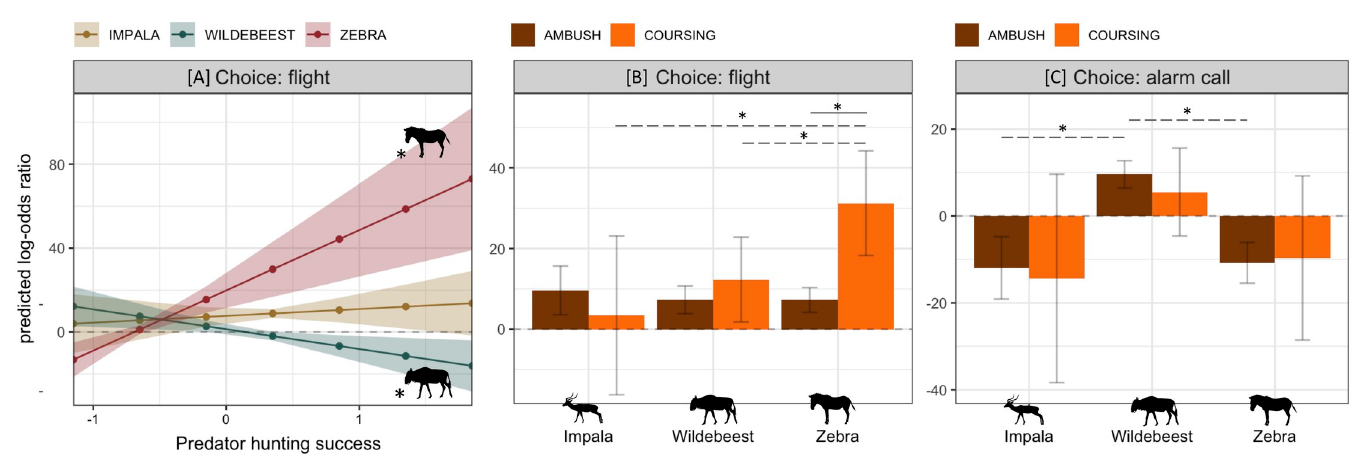
Fig 4. Strongly-supported effects on type of anti-predator behaviors chosen. [A] Zebra and wildebeest were more and less likely to flee, respectively, from increasingly successful predators. [B] Zebra were more likely to flee from coursing predators than ambush predators and fled more often from coursing predators than either impala or wildebeest did. [C] Wildebeest were increasingly likely to alarm-call in encounters with ambush predators than either impala or zebra. Depicted are log-odds ratios with associated 95% CIs. Ratios above and below 0 (dashed line) indicate that the outcome is more or less likely. For [A] and [C], solid significance lines indicate differences in response to stimuli within a species while dashed significance lines represent inter-species differences in response to the same stimulus.